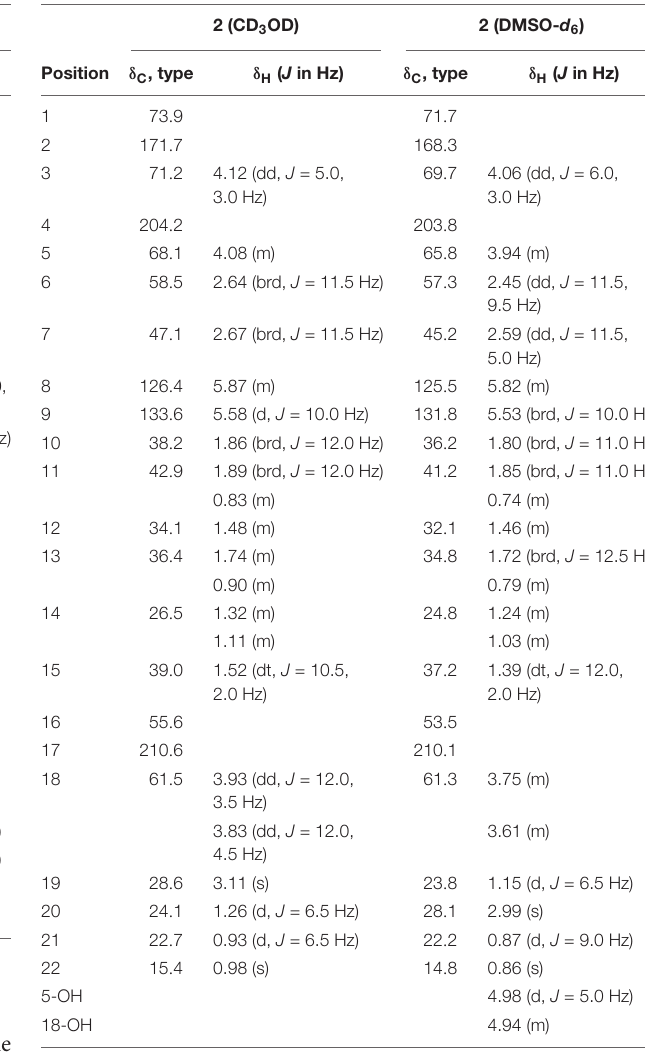
TABLE 1 | 1 H NMR Data (500 MHz, δ in ppm, J in Hz) and 13 C NMR Data (125 MHz, δ in ppm) for 1 .